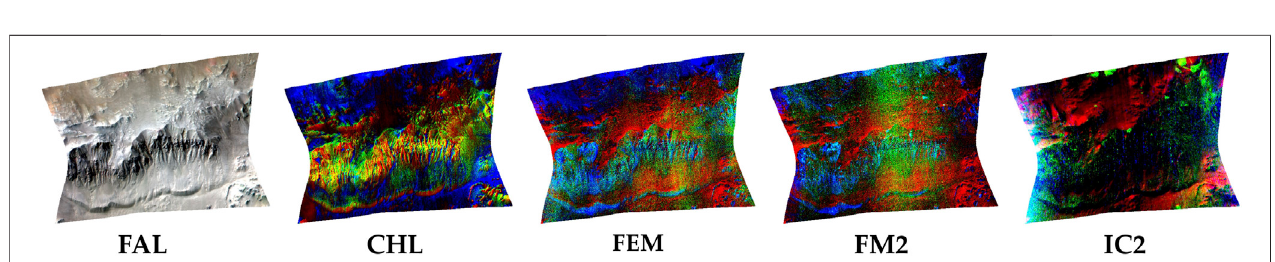
FIGURE 13 | CRISM Browse products results in Northern Hale Crater. Footprints of data are shown with red polygons in Figure 3 .